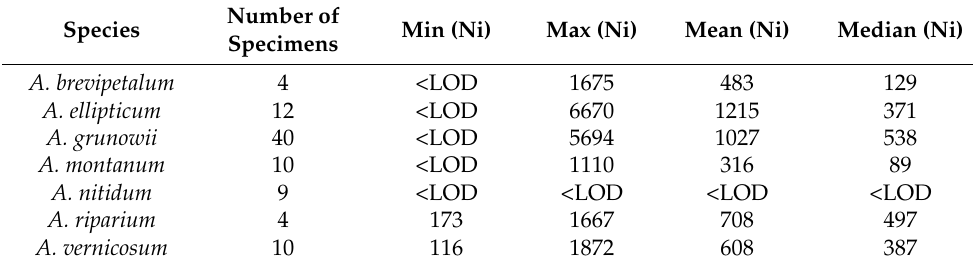
Table 1. Nickel content ( µ g · g − 1 ) measured from herbarium specimens with a handheld X-Ray Fluorescence (XRF) spectrometer. Values are in µ g · g − 1 . LOD: Level of Detection. See Appendix A for individual